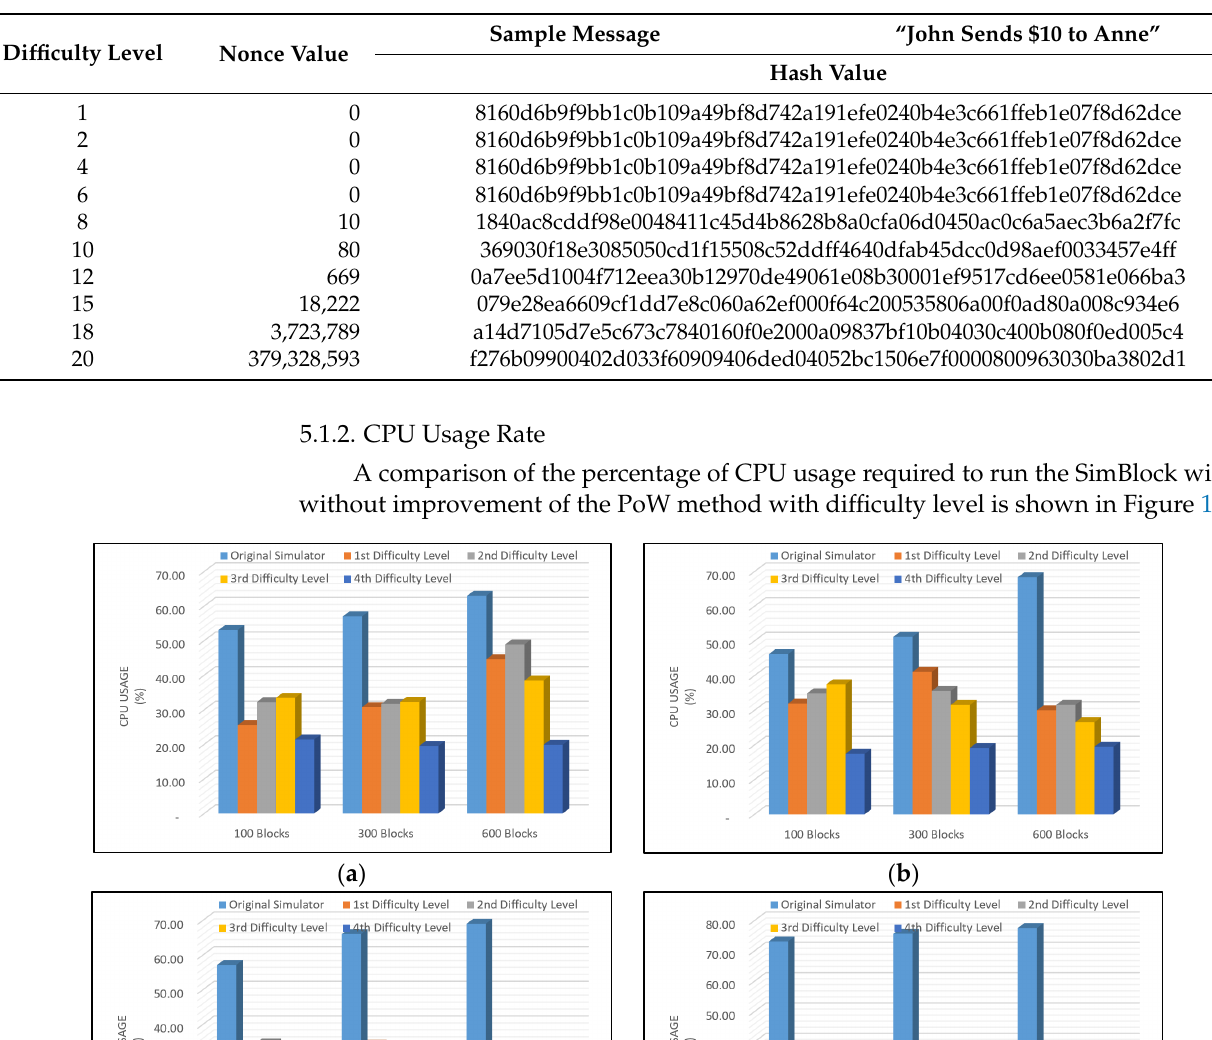
Table 4. Sample transaction and result of count-zero approach.